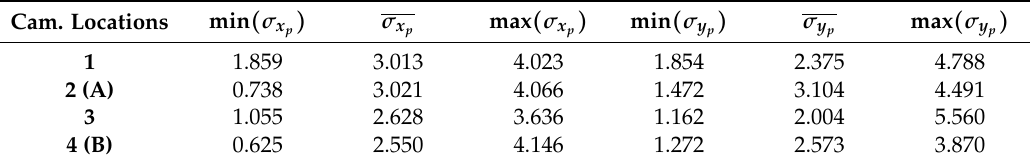
Table 5. Pixelic